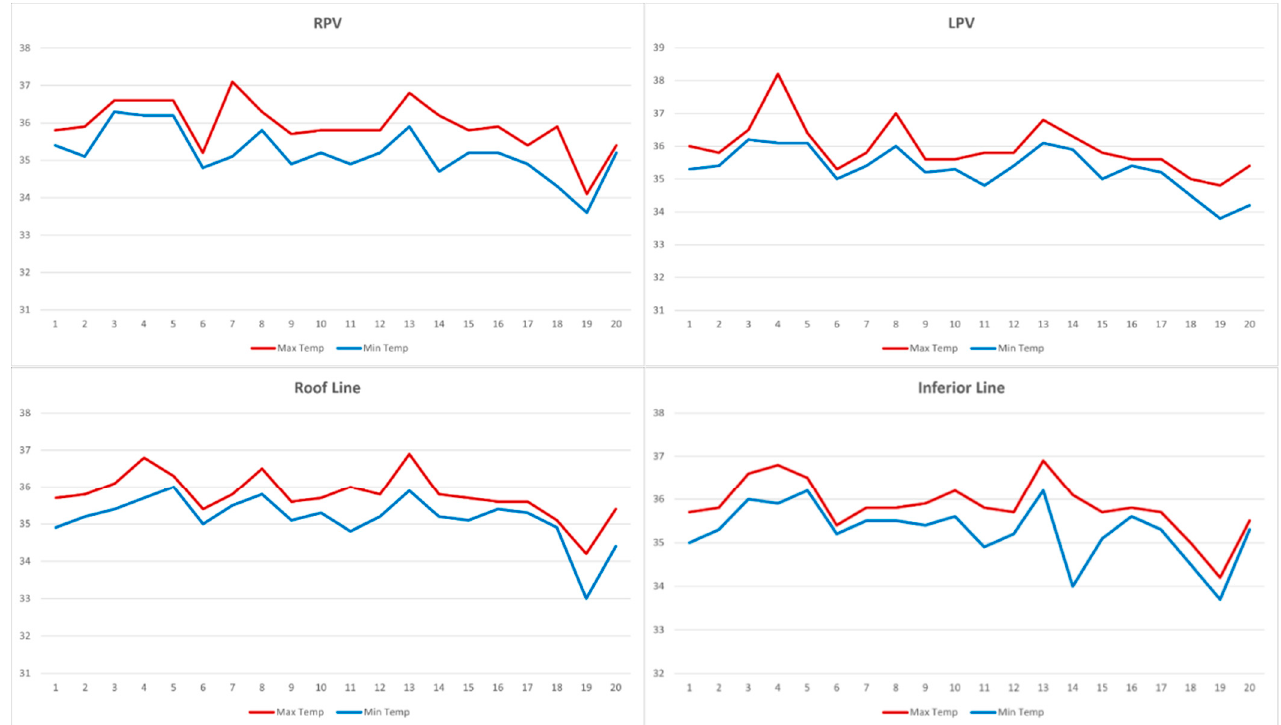
Figure 1. Maximal and minimal esophageal temperatures measured during the ablation procedure. Abbreviations: RPV: right pulmonary vein; LPV: left pulmonary vein. The x ‐ axis is the patient number; the y ‐ axis is luminal esophageal temperature (°C).